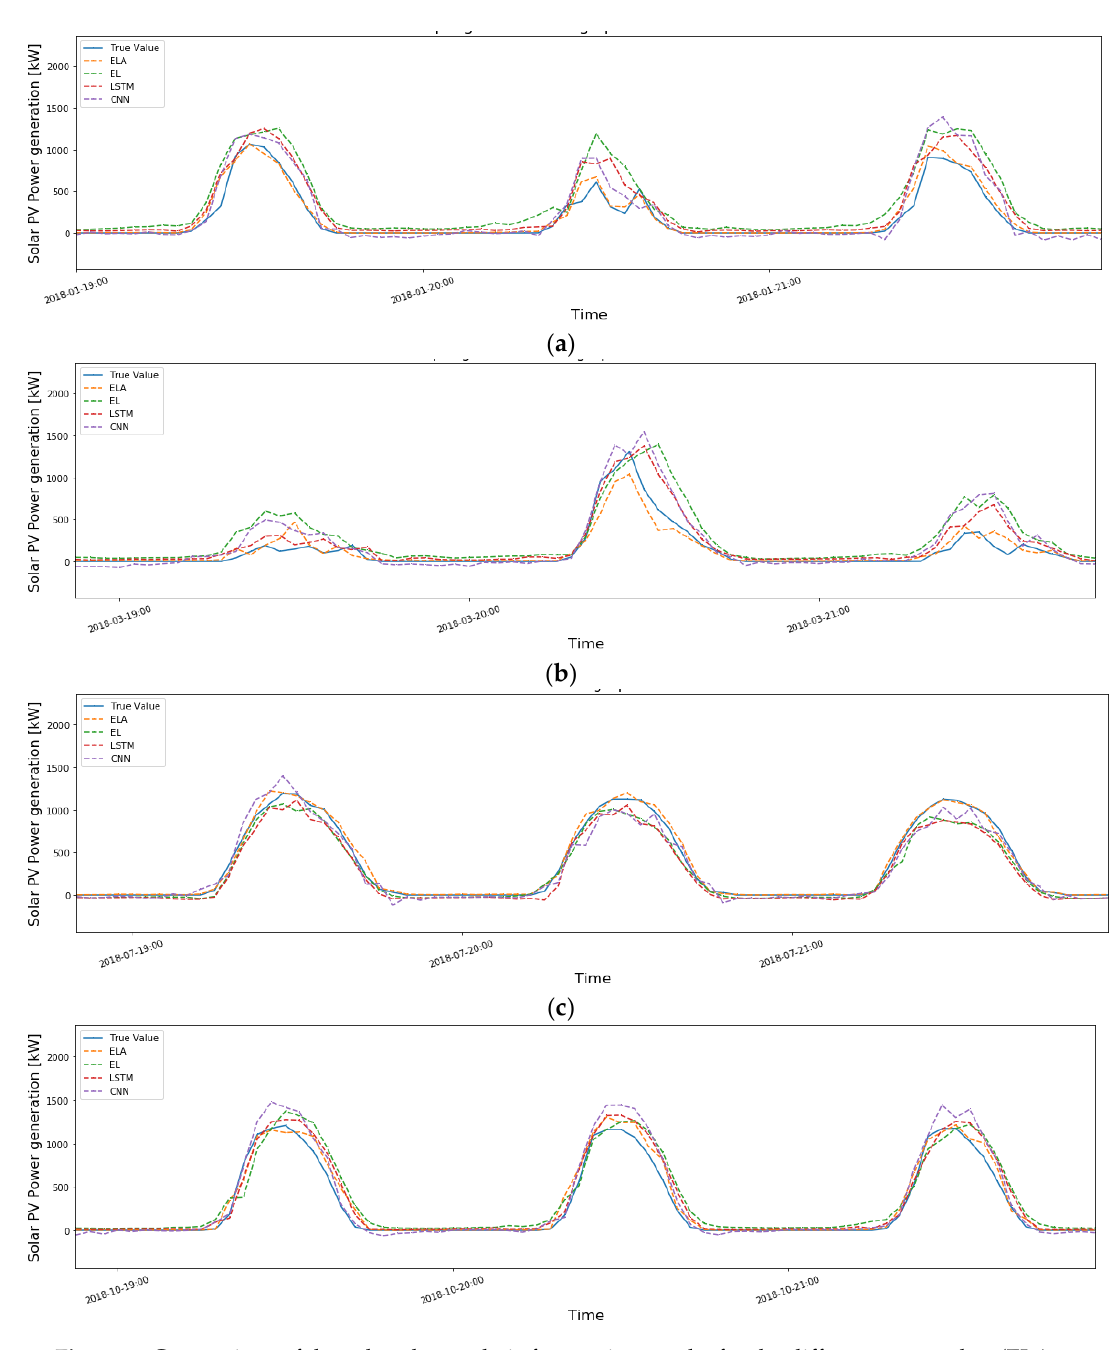
Figure 8. Comparison of the solar photovoltaic forecasting results for the di ff erent approaches (ELA, EL, LSTM, and CNN). ( a ) Case I: solar photovoltaic power prediction for winter (19–21 January 2018); ( b ) Case II: solar photovoltaic power prediction for spring (19–21 March 2018); ( c ) Case III: solar